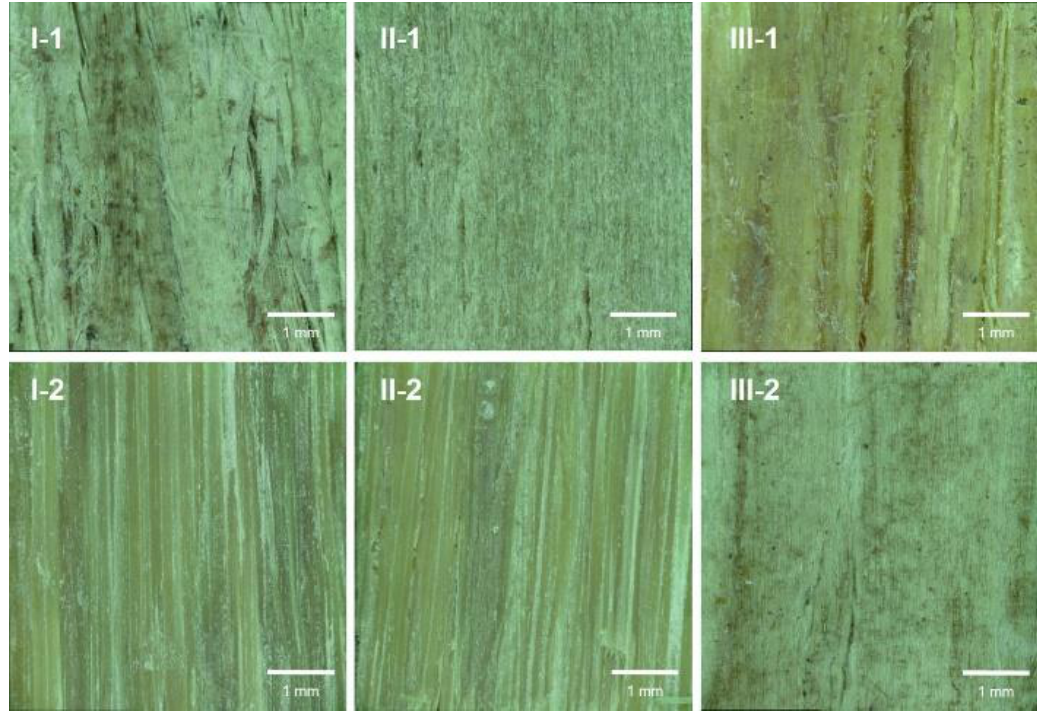
Figure 3. Surface textures of the LC samples.